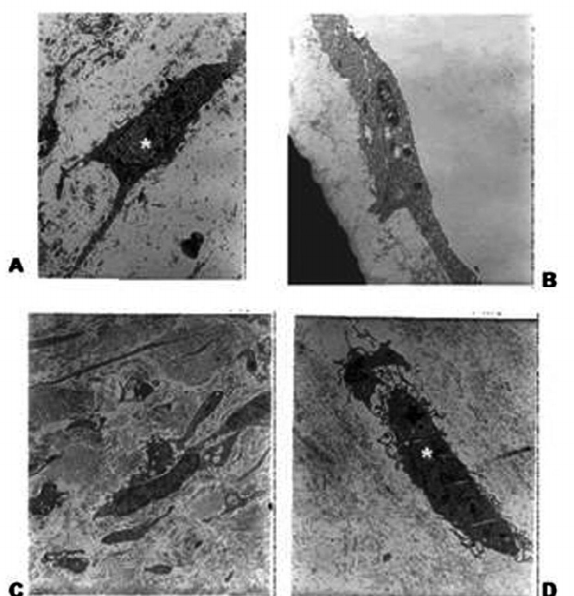
Fig.4 - Microscopia Eletrônica de Transmissão. A) Grupo L-Hydro: células intersticiais preservadas. B) Grupo L-Hydro: abundante pinocitose e grânulos citoplasmáticos eletrodensos nas células superficiais compatíveis com células endoteliais em processo de diferenciação. C) Grupo homoenxerto a fresco: célula intersaticial alongada bem preservada. Asteriscos ressaltam as células